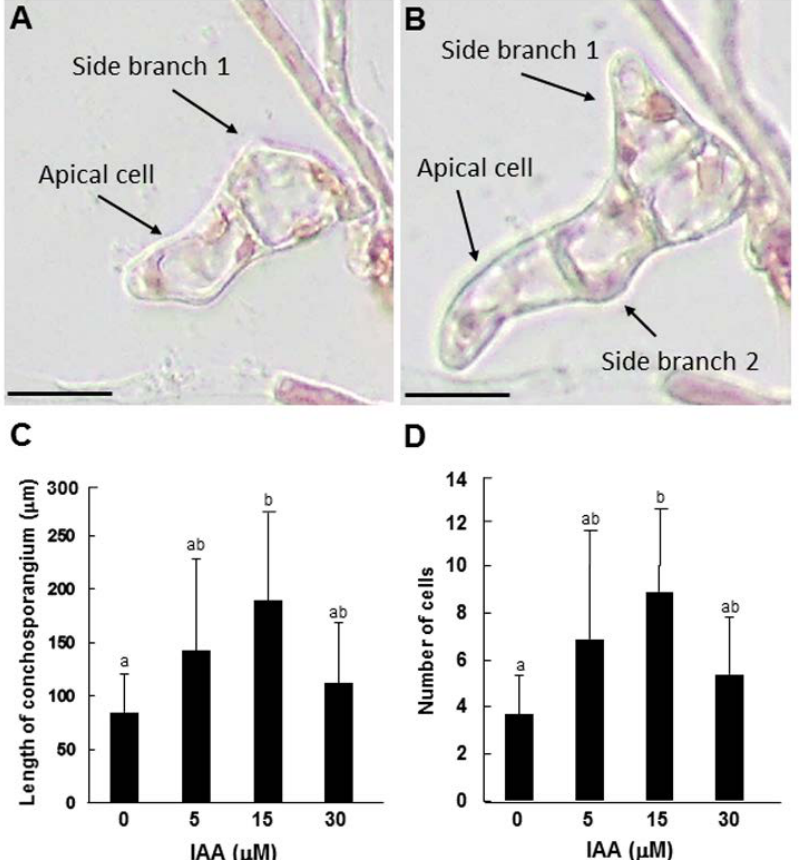
Figure 5. Effects of IAA on the tip growth of conchosporangia produced on conchocelis filaments. ( A , B ) The pattern of tip growth and side branch formation in a conchosporangium cultured for 2 ( A ) and 3 ( B ) days, after swelling of the tip of the side branch from a single-celled conchocelis. The apical cells and side branches are indicated by arrows. Scale bars: 25 μm. ( C , D ) Effects of exogenously supplied IAA on the growth of side branches from single-celled conchosporangia, including total length ( C ) and cell number ( D ) after 7 days of culture. Error bars indicate the standard deviation of triplicate independent experiments ( n = 3), and different lowercase letters denote significant differences, as determined by Tukey’s test ( p < 0.05).